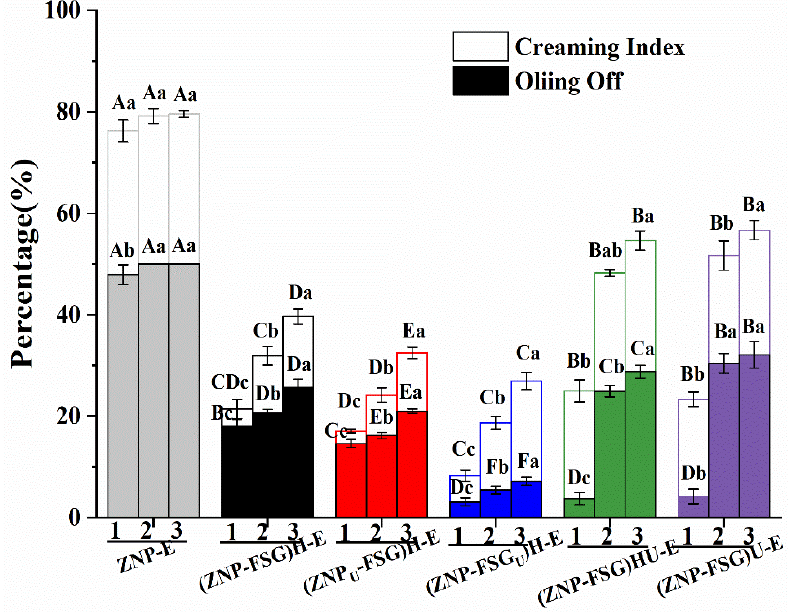
Figure 7. The oiling off and creaming index of the Pickering emulsions stabilized by ZNP-FSG complexes subjected to various ultrasound and homogenization treatments. 1, 2, 3 represent freeze-thaw cycles, respectively.